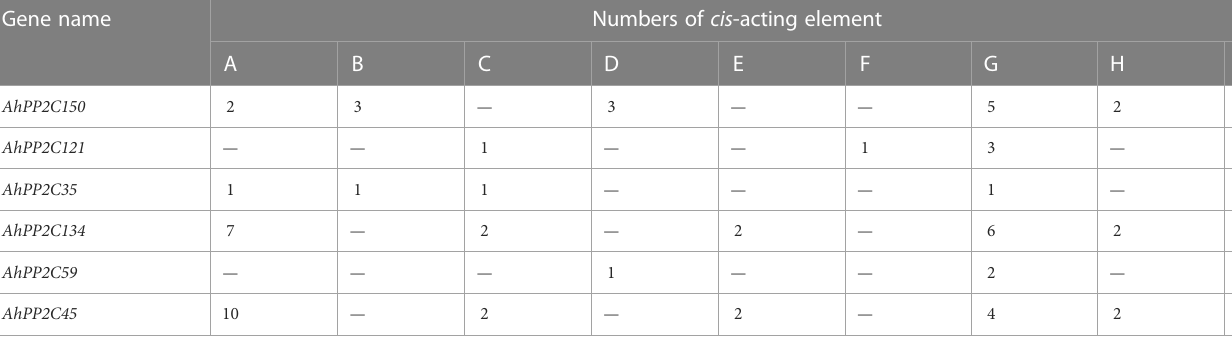
TABLE 2 The Distribution of Cis -Acting Elements in AhPP2C s of Subclades AI and AII. Gene name